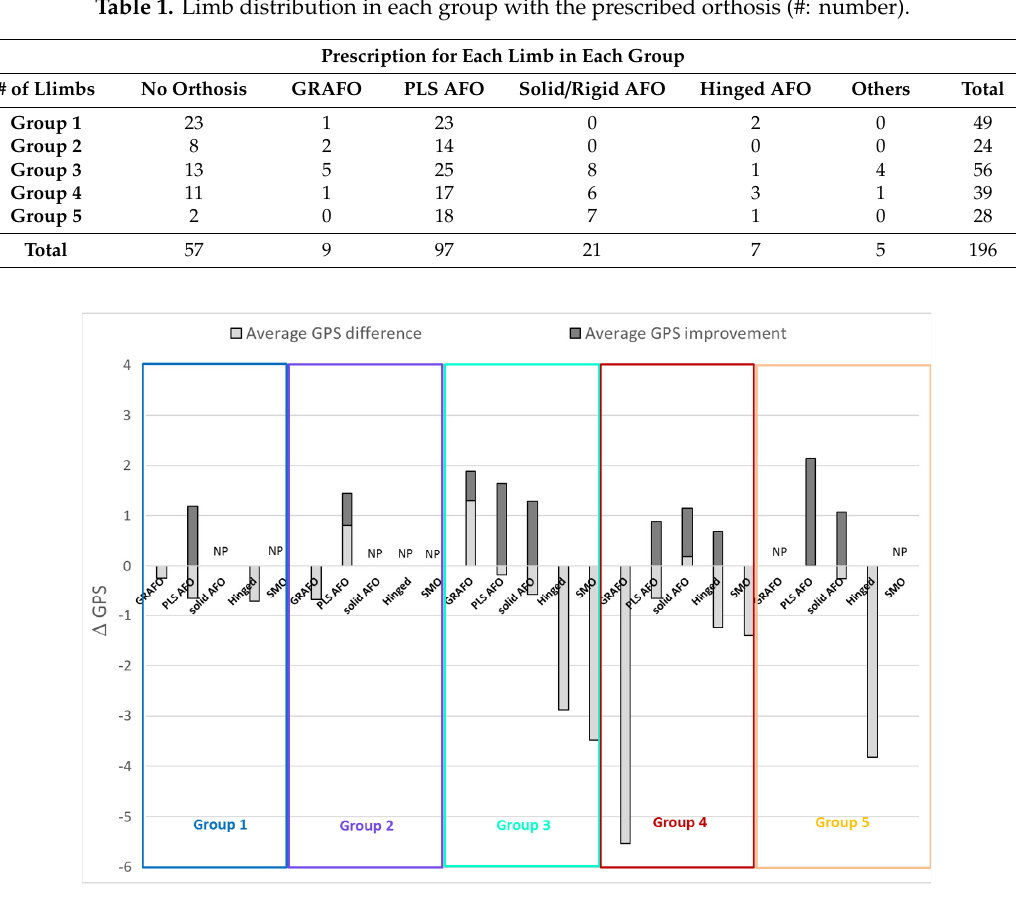
Figure 8. Average gait profile score (GPS) differences between walking barefoot and with the prescribed orthosis per group and per AFO. Light grey bars represent the average GPS difference (average Δ GPS = sum ( Δ GPS)/#limbs) and dark grey bars represent the average GPS improvement (Average + Δ GPS = sum (+ Δ GPS)/#limbs with improved GPS), i.e., when improved GPS limbs were taken into consideration. Δ GPS = (GPS barefoot ₋ GPS orthosis), + Δ GPS is when the difference was positive (improvement OF GPS with AFO), NP: not prescribed to the group, GRAFO: ground reaction AFO, PLS AFO: posterior leaf spring AFO, SMO: supra malleolar orthosis, #: number of.